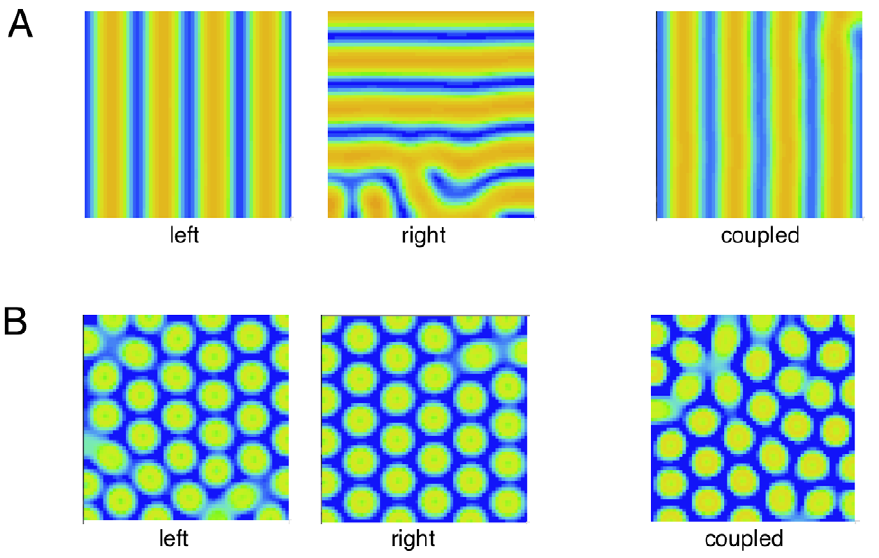
Figure 11. Steady state for 64 | 64 arrays with and without coupling. (A) Period 55 msec without coupling (left two images) and coupled c ~ 0 : 02 right image. (B) same as (A) but period is 120 msec.